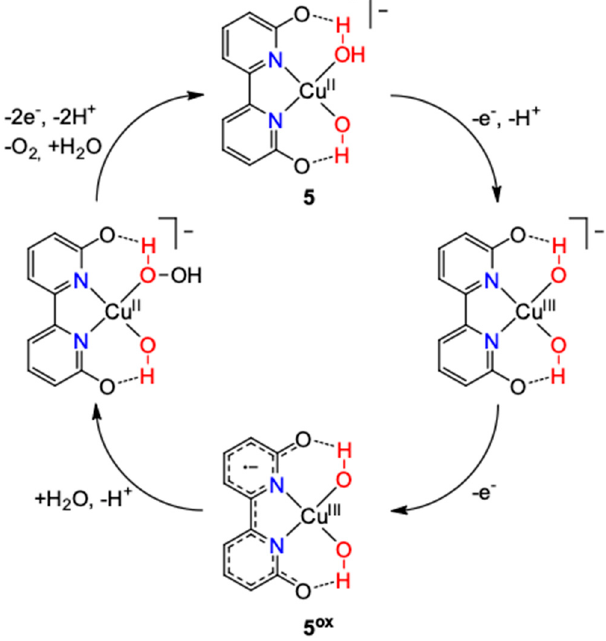
Figure 7. The most probable pathway of catalysis by 5 [31].